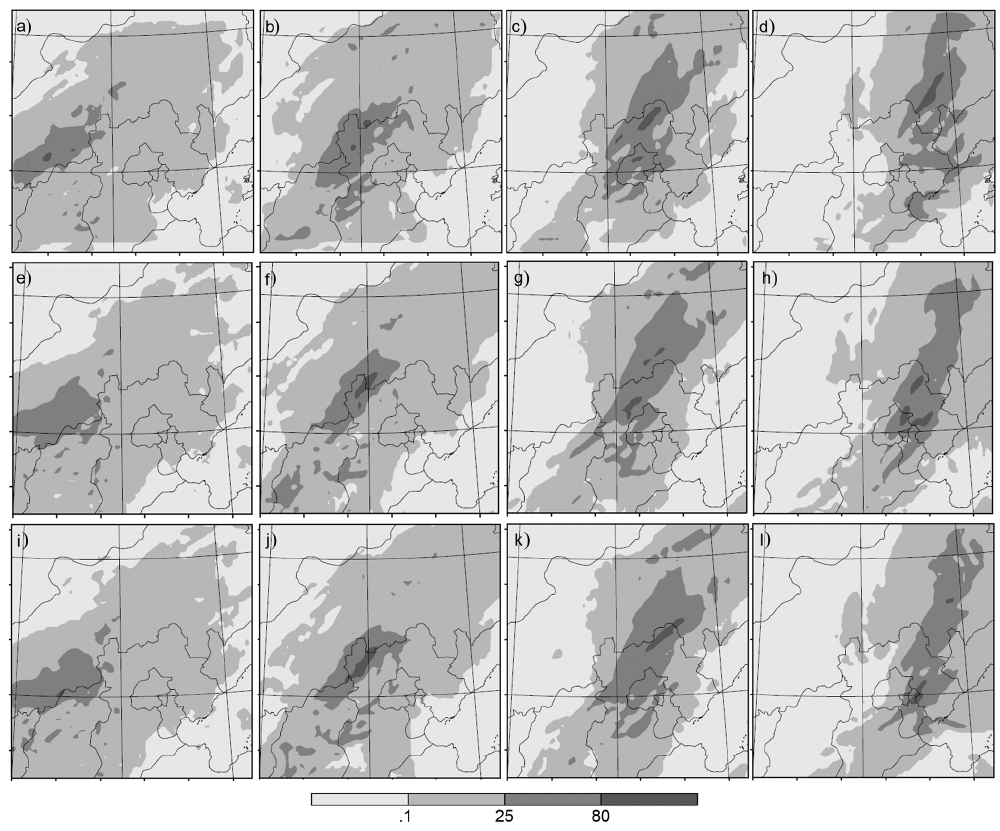
Figure 4. Spatial distribution of 6-h accumulated precipitation for the domain size experiments over the domain two area of C0 during the Beijing heavy rainfall event beginning at 12:00UTC on 21 July 2012. (a) Accumulated precipitation (AP) in C0 during the first 6h period (00:00–06:00UTC); (b) AP in C0 during the second 6h period (06:00–12:00UTC); (c) AP in C0 during the third 6h period